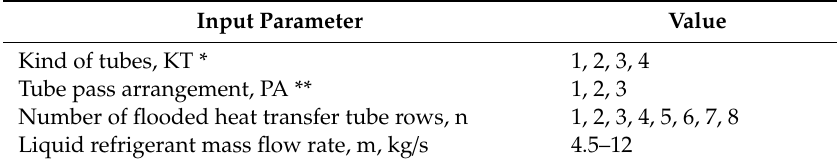
Table 3. The inputs employed for training and testing of the AGENN